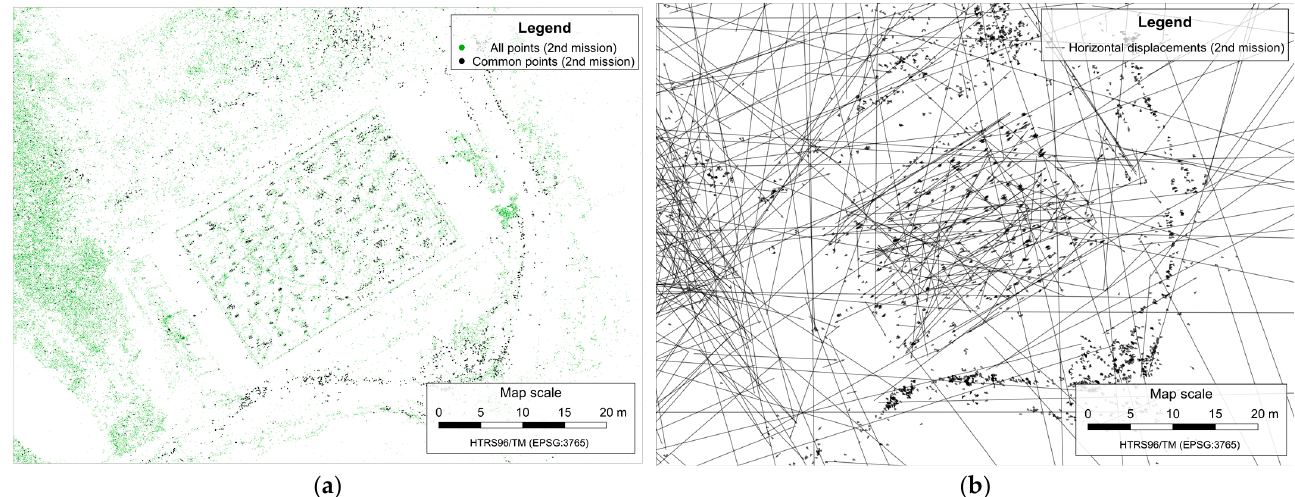
Figure 7. All reconstructed points with highlighted common feature points in the second mission ( a ), and determined horizontal displacements vectors ( b ).